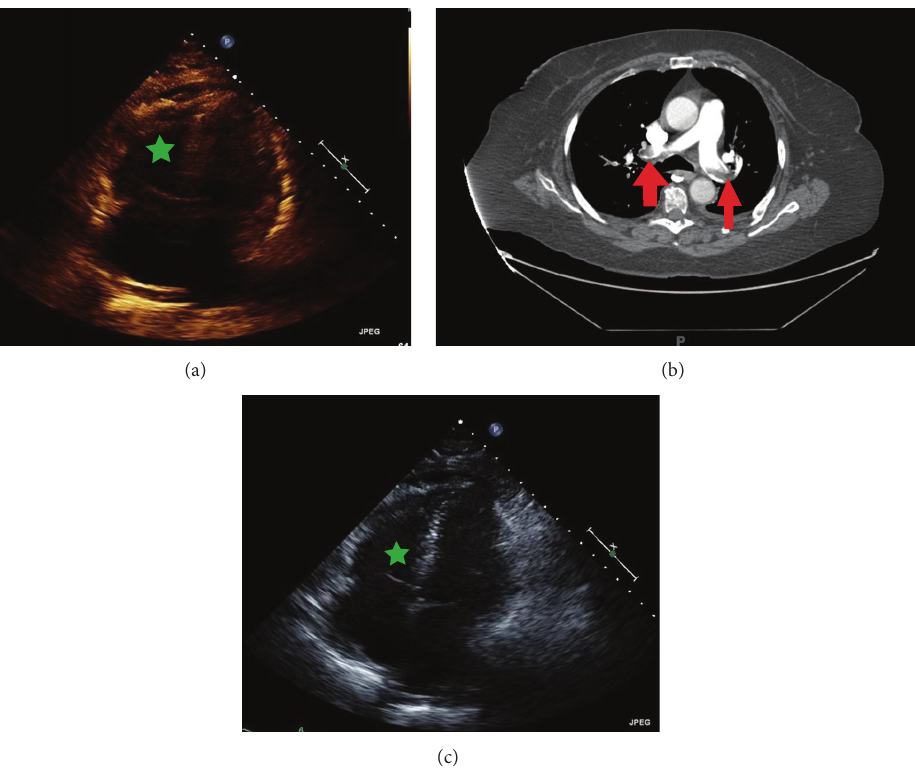
Figure 4: (a) The right ventricle is dilated and the septum is flattened (green asterisk). (b) The red arrows point at multiple bilateral emboli. (c) The image shows improvement in right ventricle dimension after the